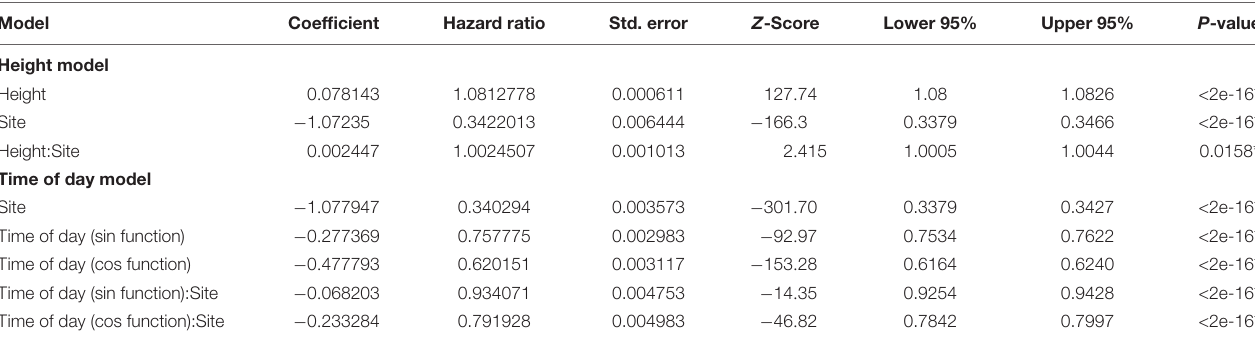
FIGURE 2 | Average air speeds ( ± standard deviation) and turbulence score at different heights from the ground for our early successional and late successional forest sites, generated from Kaplan–Meier estimates. TABLE 1 | Results of cox proportional hazard models for mean air speed by vertical position and time of day (i.e., diel cycle). Model Coefficient Hazard ratio Std. error Z -Score Lower